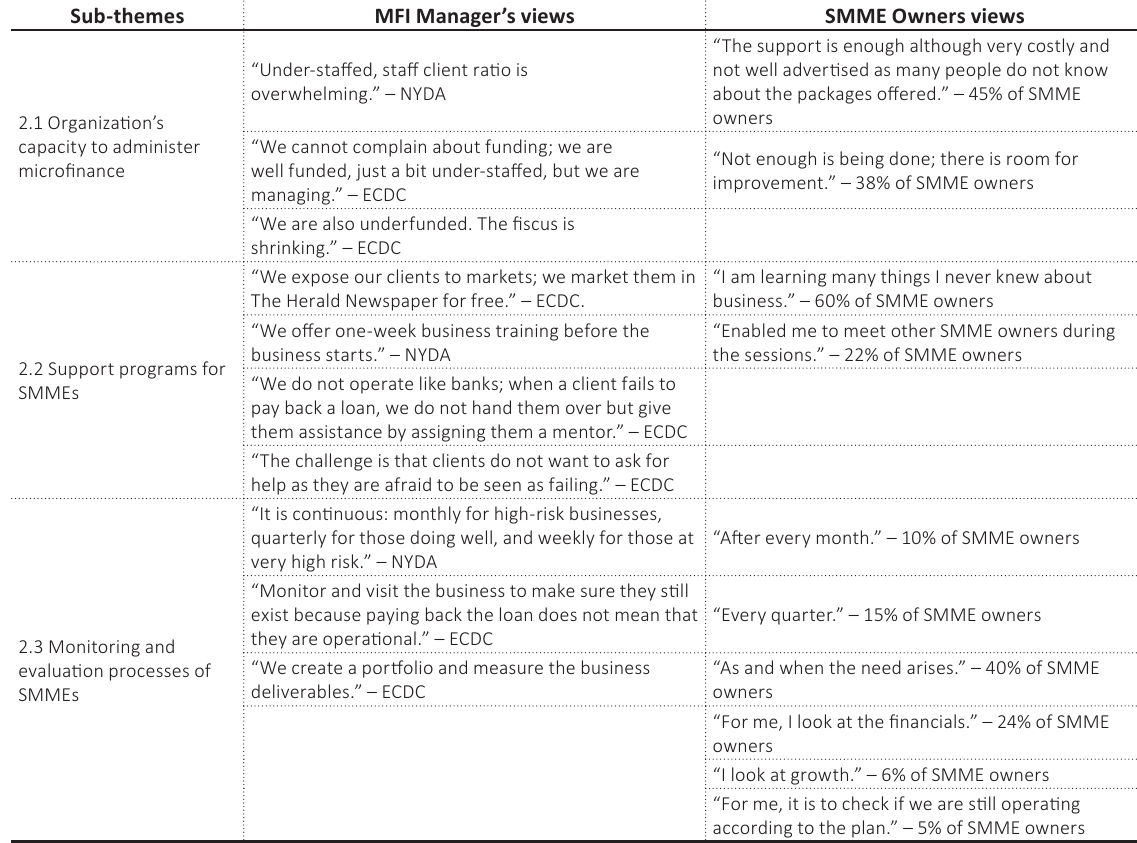
Table 2. MFIs’ capacity to administer